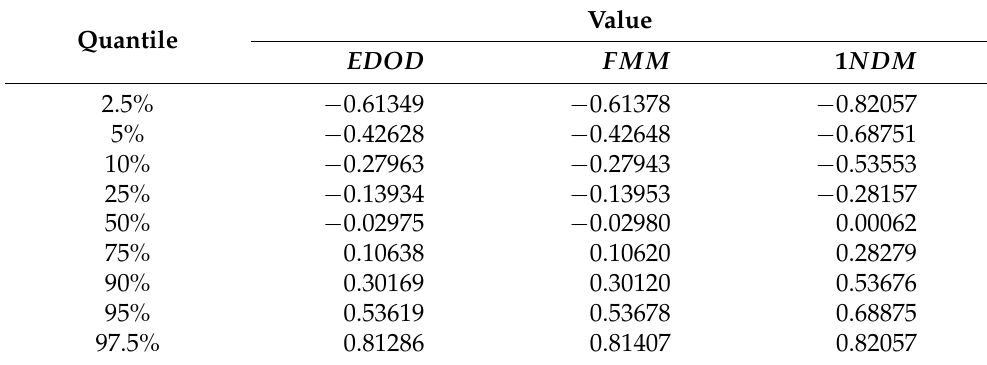
Table 3. Comparison of quantiles for the Finite Mixture Model ( FMM ), the One Normal Distribution Model (1 NDM ) and the empirical distribution of observed data ( EDOD ).